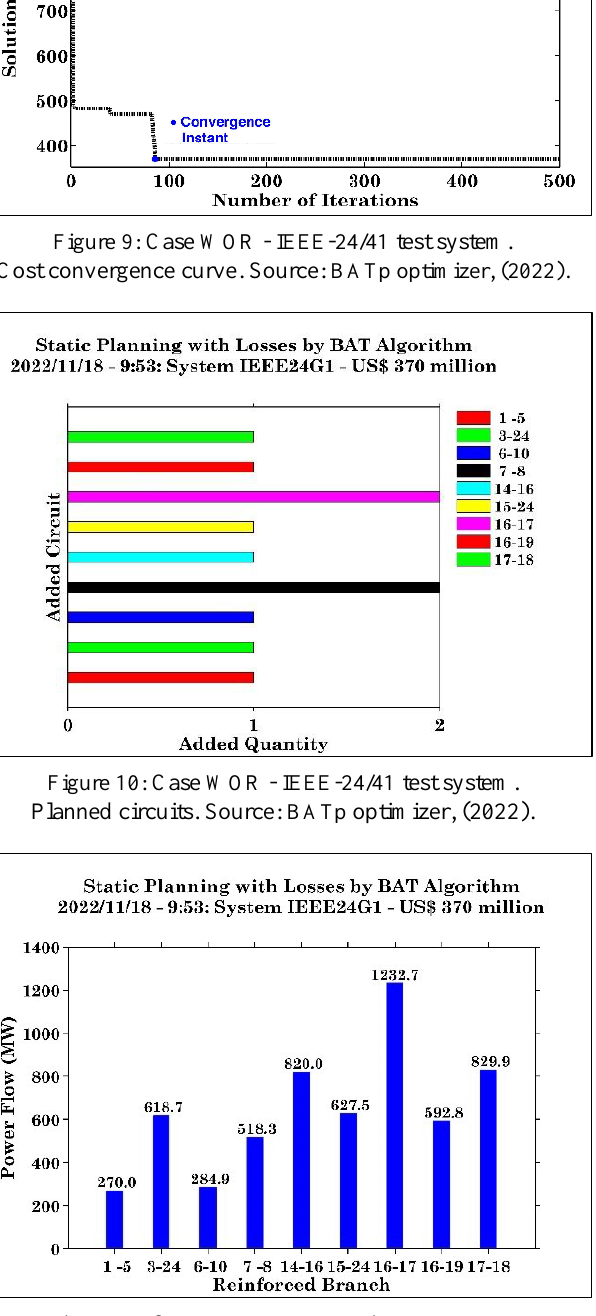
Figure 11: Case WOR - IEEE-24/41 test system. Flows in the branches. Source: BATp optimizer, (2022).